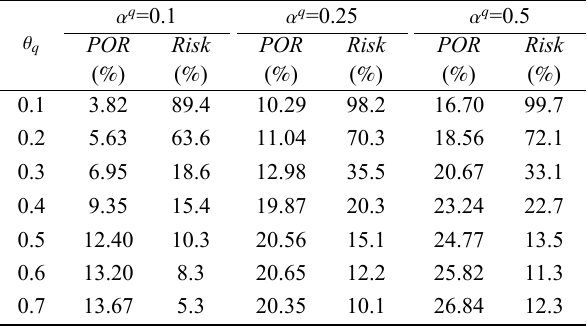
Table 7 POR and Risk for instance with 100